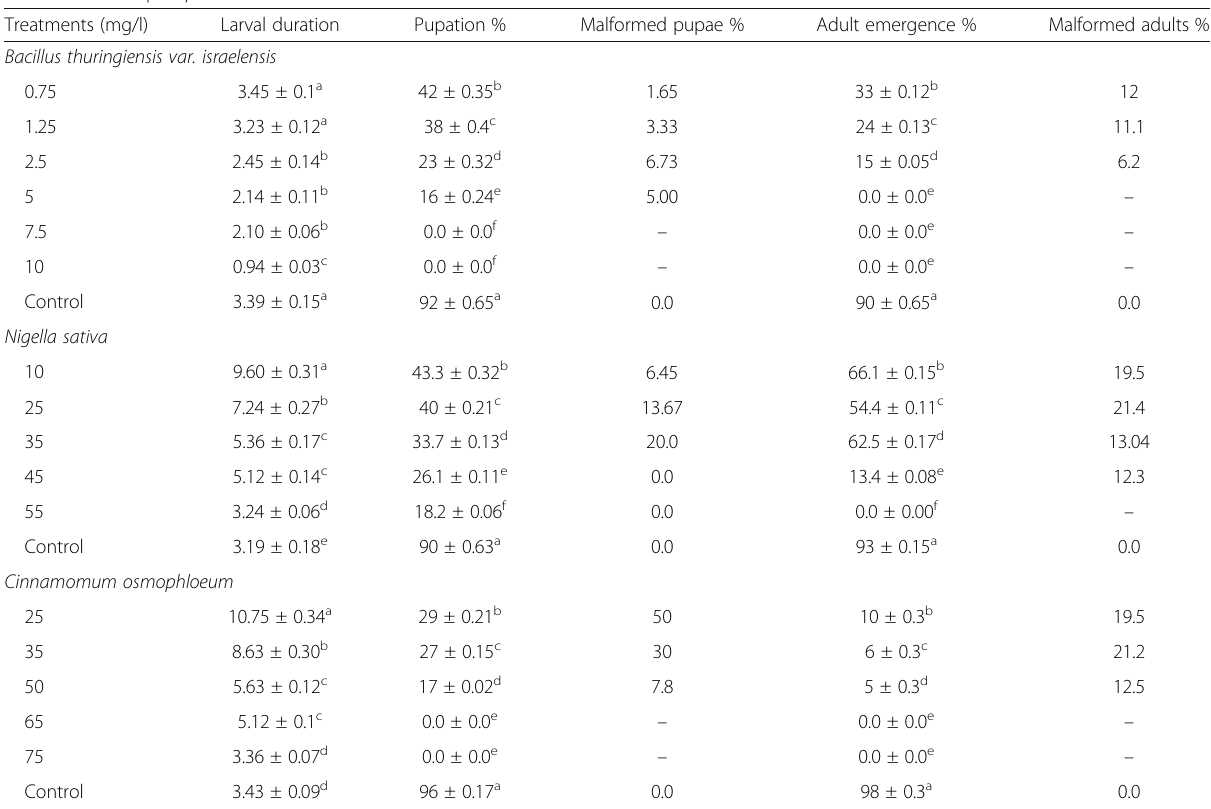
Table 2 Effect of Bacillus thuringiensis var. israelensis and some plant extracts on some biological aspects after treatment of 4th instar larvae of Culex quinquefasciatus